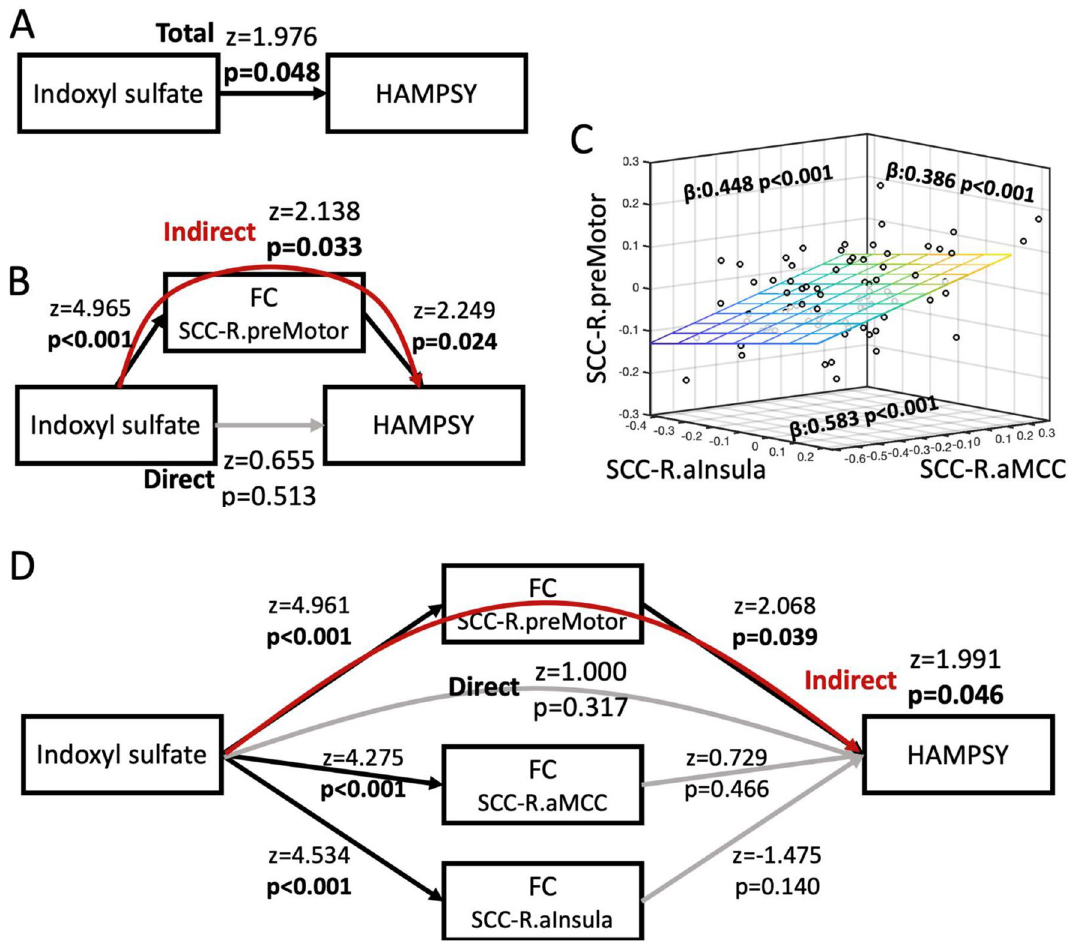
Figure 5. The impact of indoxyl sulfate on psychic anxiety scores is mediated by its effects on the resting state functional connectivity between the subcallosal cingulate cortex and the right premotor region. ( A ) Association between indoxyl sulfate and psychic anxiety scores. ( B ) Mediation model incorporating the overlapping area, right premotor region, indicating that the effect of indoxyl sulfate on psychic anxiety is mediated via its effects on the functional connectivity between the SCC and right premotor region. ( C ) Significant SCC-FC correlations between the right anterior insula, right anterior midcingulate cortex, and right premotor region, which were included in the mediation model shown in ( D ). ( D ) Full mediation model incorporating the three regions showing significant SCC-FC correlations with indoxyl sulfate abundances. Although indoxyl sulfate is significantly correlated with all three regions, only the pathway through the right premotor region significantly mediates indoxyl sulfate’s effect on psychic anxiety. Black lines indicate significant associations within the model; grey lines are insignificant associations. Red line indicates significant mediation of indoxyl sulfate on psychic anxiety through the indirect pathway of right premotor SCC-FC. HAMPSY Psychic anxiety subscore of the Hamilton Anxiety Rating Scale. SCC-FC subcallosal cingulate cortex functional